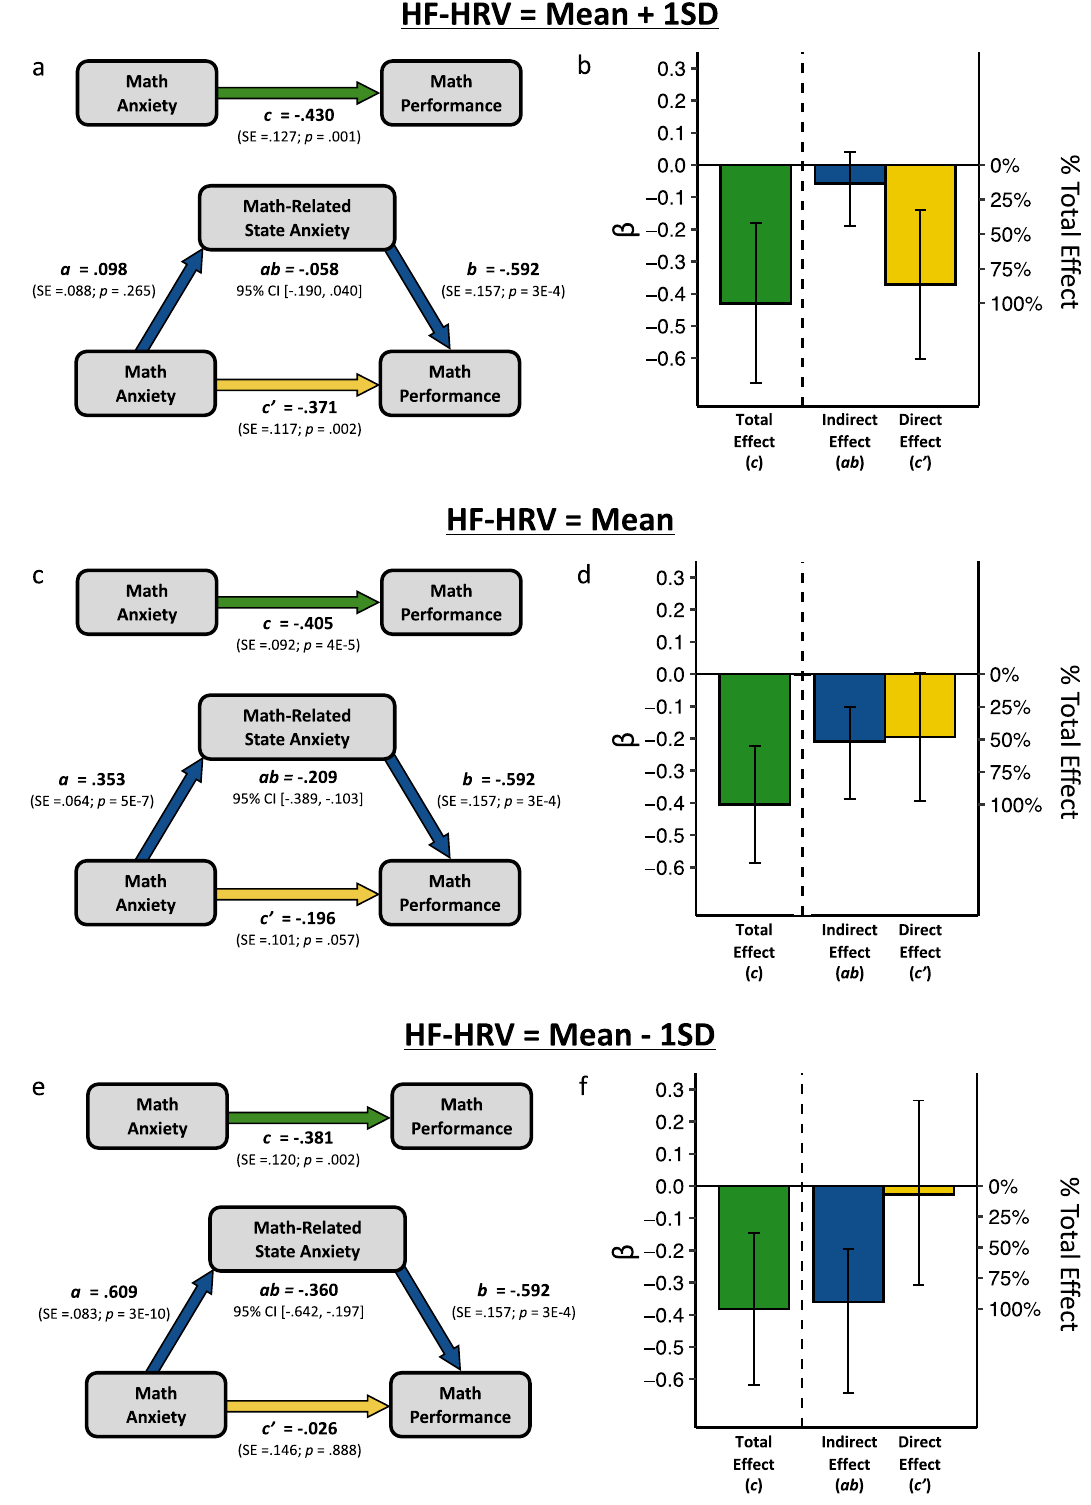
Fig. 6 Mediating role of math-related state anxiety by HF-HRV levels. Figure shows the predicted mediation models for individuals at different levels of HF-HRV using simple slope analyses generated by the fi nal conditional process model shown in Fig. 6. (In this model, the a and c paths were allowed to vary, while the b path was not because no signi fi cant moderation of the b path was observed; see text for details.) ( b , d , f ) visualize the magnitudes of the total effect of math anxiety on math performance (green), the indirect (mediation) effect via math- related state anxiety (blue), and the direct effect of math anxiety on math performance after controlling for math-related state anxiety (yellow). Error bars represent 95% con fi dence intervals for the beta